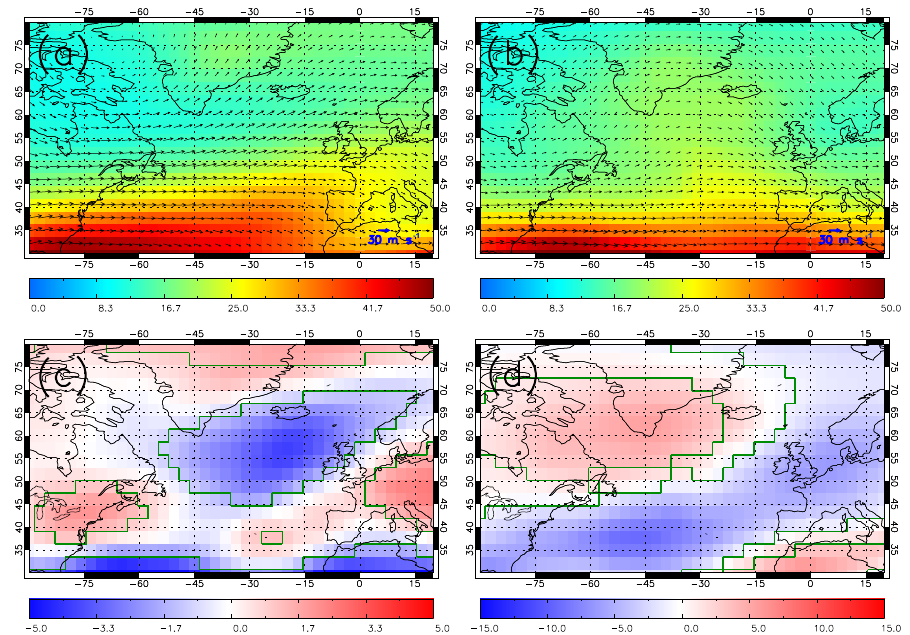
Figure 10. TOMCAT PAN (pptv) averaged between 200 to 100hPa for 2006–2015 sampled under the wintertime (NDJF) NAO. Panel (a) NAO positive phase, (b) NAO negative phase, (c) shows the NAO positive phase anomaly relative to the wintertime average and (d) shows the negative NAO phase anomaly relative to the wintertime average. Wind vectors show the horizontal 200–100hPa winds. Green polygon- outlined regions in (c) and (d) highlight significant differences at the 95% confidence level based on the